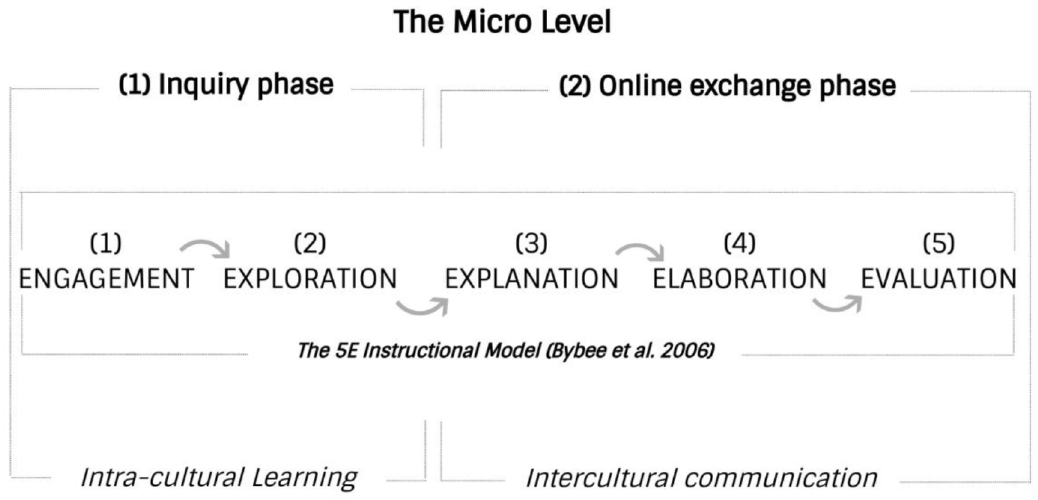
Figure 3. The inquiry-based model of telecollaboration (micro